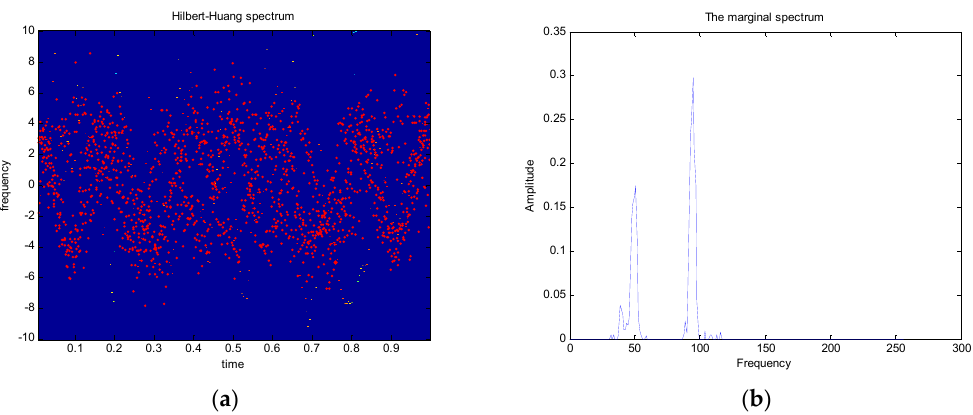
Figure 6. Hilbert spectral analysis: ( a ) Hilbert-Huang spectrum; ( b ) the marginal spectrum.